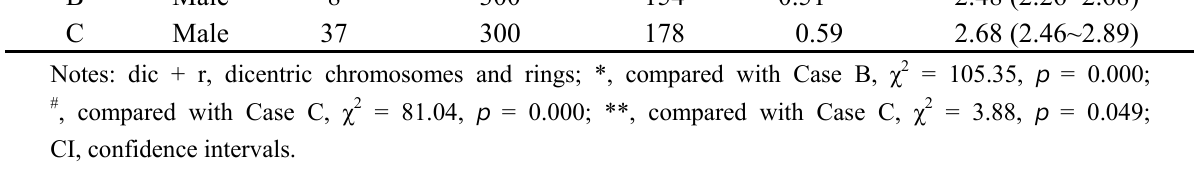
Figure 1. Multiple chromosome aberrations in a lymphocyte from Case A. 1 , dicentric chromosomes; 2 , centric rings; 3 , acentric